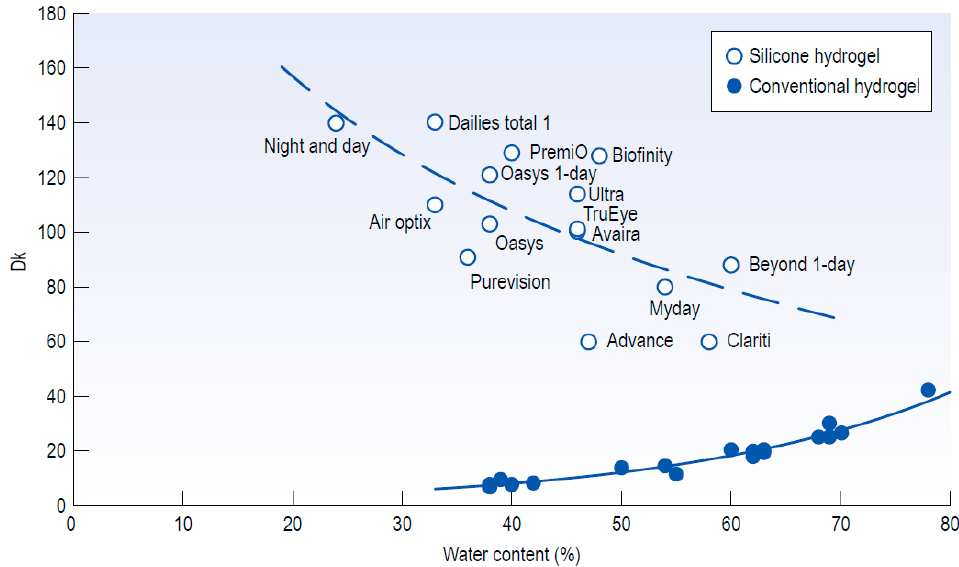
Figure 4. Relationship between Dk and EWC for conventional hydrogel and silicone hydrogel lenses, unit Dk (Barrer) = 10 − 11 cm 2 ∗ ml O 2 / ( s ∗ ml ∗ mm Hg ) [73].